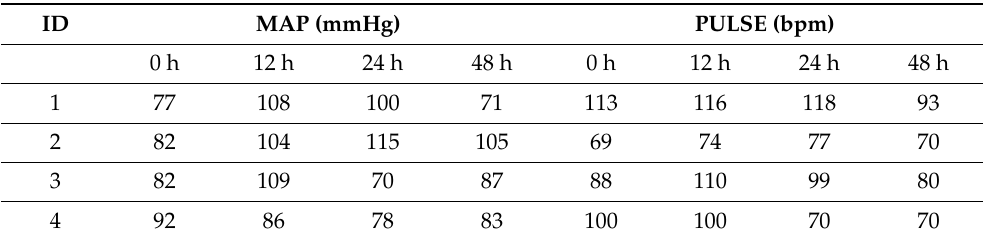
Table 2. Mean arterial pressure (MAP) and pulse values before (0 h) and 12, 24 and 48 h after performing segmental lung recruitment. ID MAP